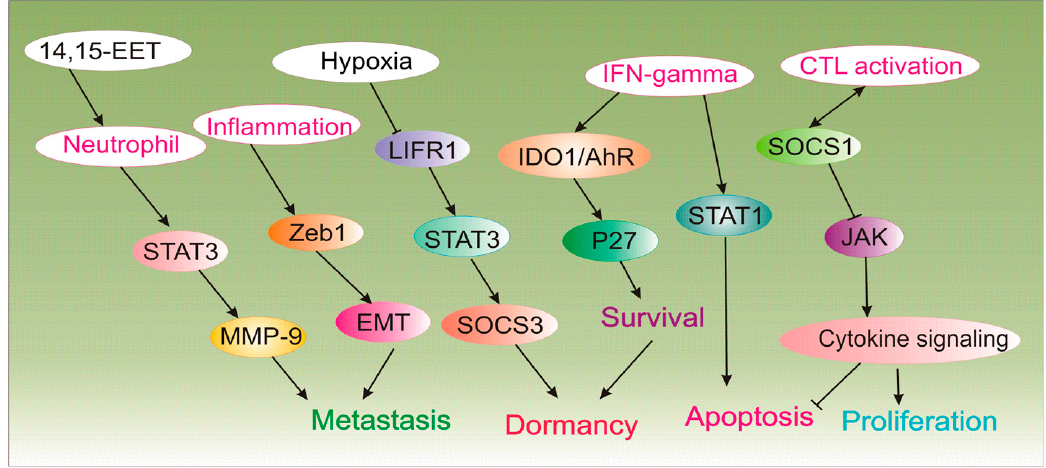
Figure 1. The implication of the immune system in tumor cell dormancy.